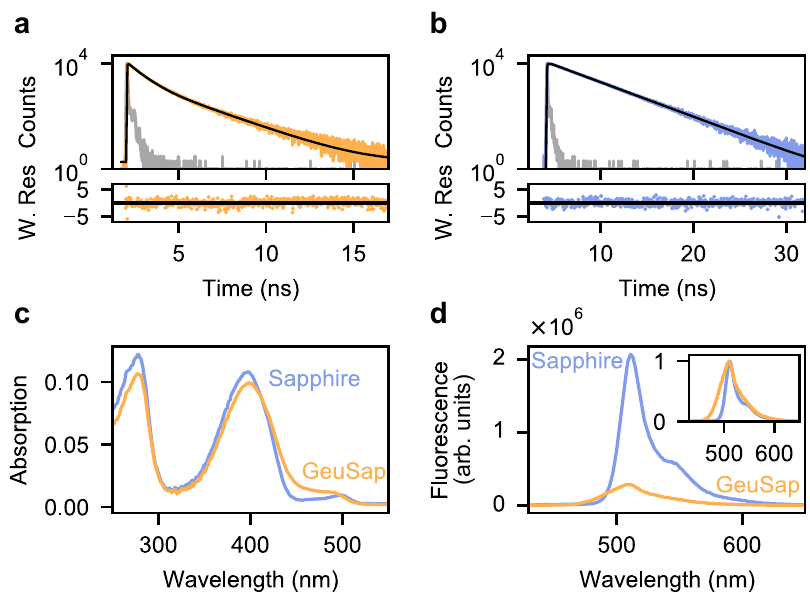
Fig. 1 Spectral characteristics of GeuSap and Sapphire. a Fluorescence decay of GeuSap (orange) on 400 nm excitation and 510 nm detection, measured with TCSPC. The model used for fi tting (black) is a bi-exponential function with reconvolution, yielding two lifetimes τ 1 = 0.58 ns (70%) and τ 2 = 1.7 ns (30%). IRF is in gray. Weighted residuals are shown in the bottom panel ( χ 2 = 1.2). b Fluorescence decay of Sapphire (blue). The model used is a mono- exponential function with reconvolution (black), τ = 3.3 ns and χ 2 is 1.08. c Absorption spectra of GeuSap and Sapphire. d Emission spectra of GeuSap and Sapphire upon excitation at 400nm. Optical density at the excitation wavelength was adjusted to 0.1 for both samples. Inset shows normalized emission spectra. W. Res.: weighted residuals. Source data are provided as a Source Data fi